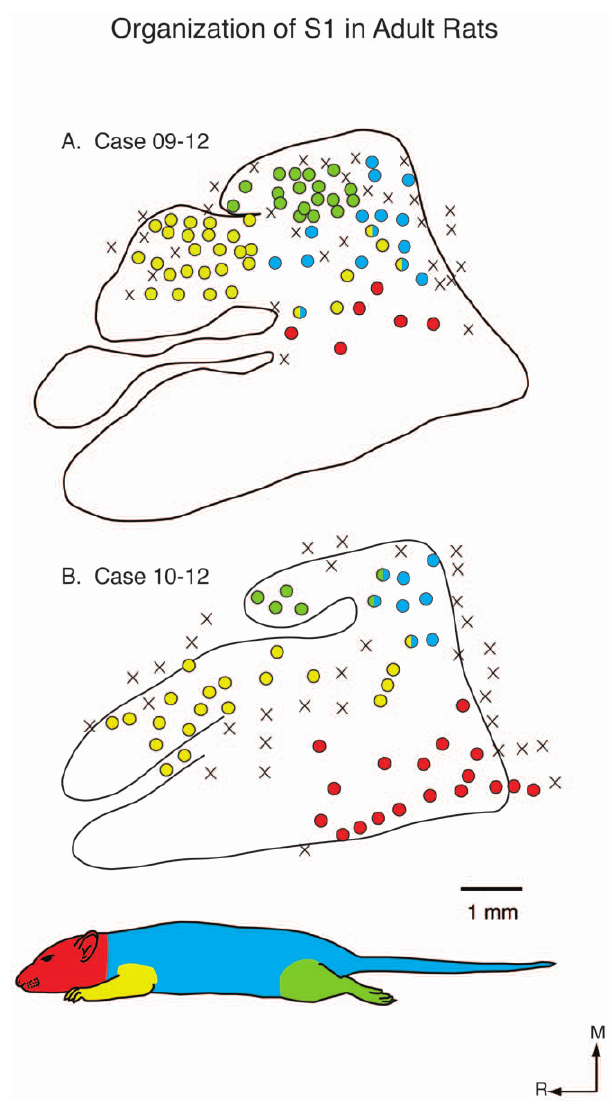
Figure 10. Functional S1 maps in adult rats. Reconstructed functional maps of primary somatosensory cortex in adult rats (A and B). In adult rats the topographic organization is precise and consistent across animals and similar to that previously described (Chapin and Lin,